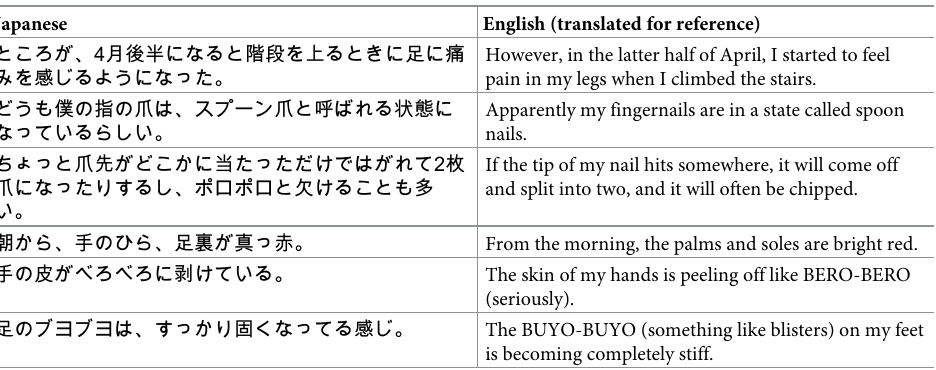
Table 2. Examples of HFS positive sentences. Japanese